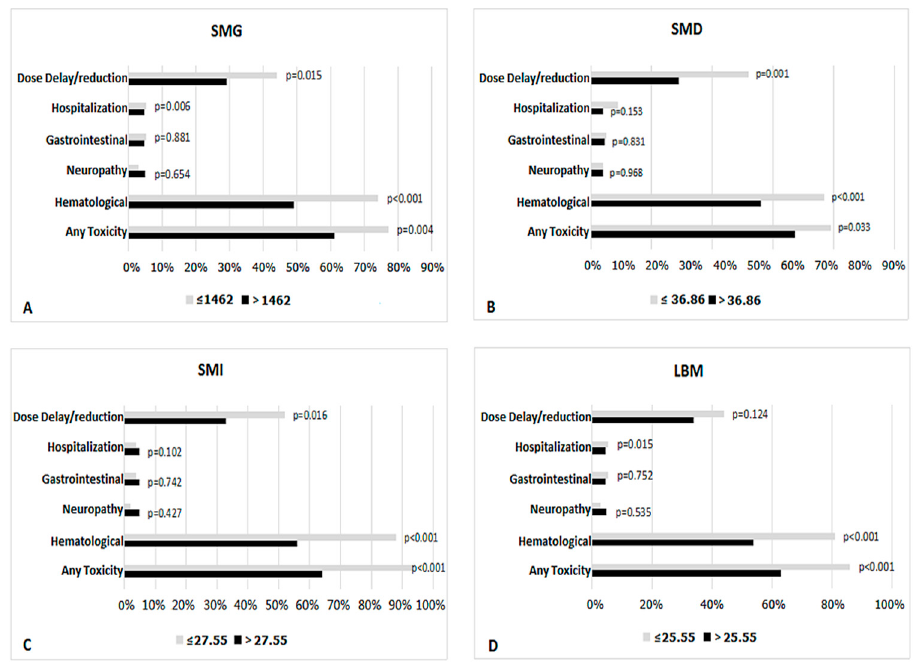
Figure 2. Risk of toxicity based on body composition. ( A ) SMG (skeletal muscle gauge), ( B ) SMD (skeletal muscle density), ( C ) SMI (skeletal muscle index), ( D ) LBM (lean body mass).